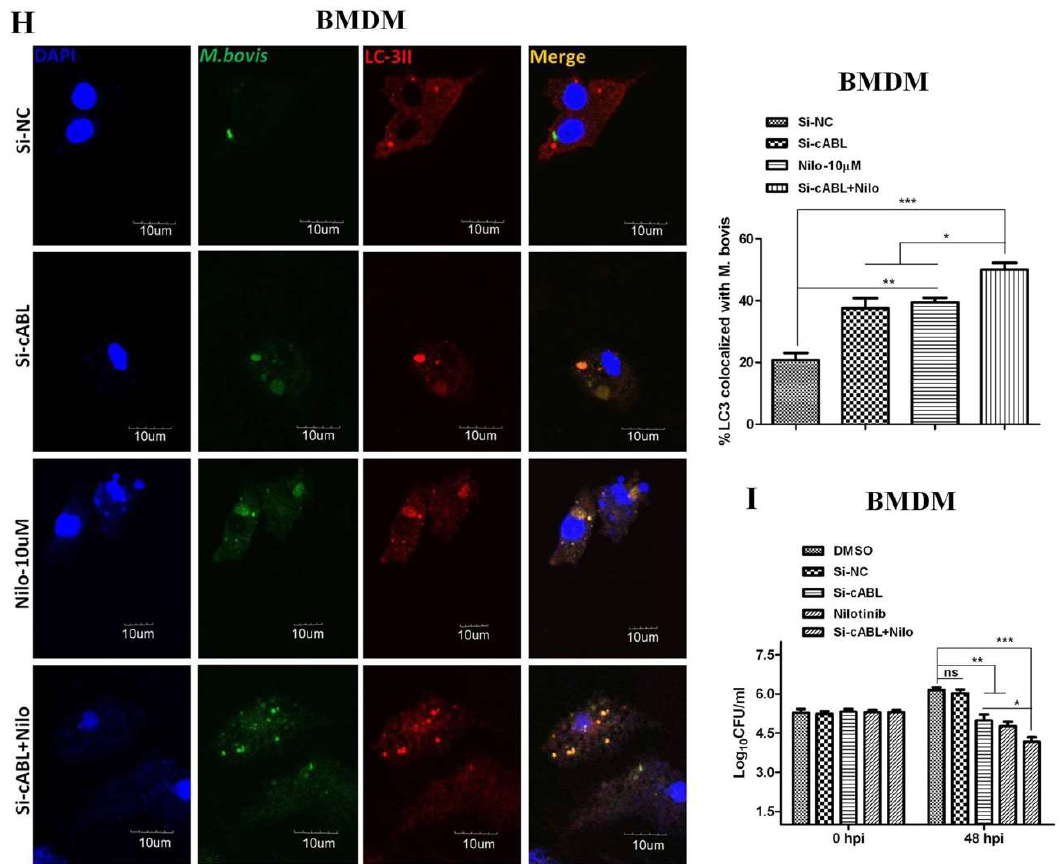
Figure 3. Nilotinib attenuates c-ABL (abelson tyrosine kinase) dependent PI3k/Akt/mTOR signaling pathway in M. bovis infected macrophages. ( A ) and ( C ) BMDM and ( B ) and ( D ) RAW264.7 cells